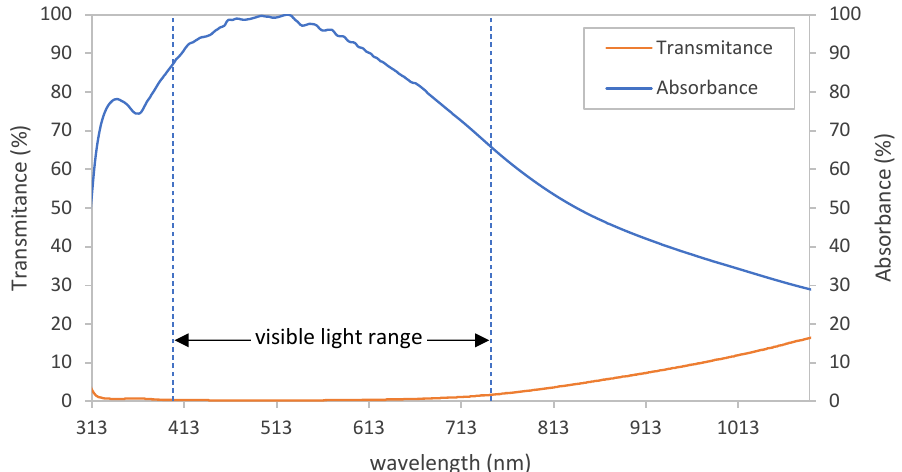
Figure 13. UV-Vis analysis of pyrite thin film on a glass substrate. Figure 13 . UV ‐ Vis analysis of pyrite thin film on a glass substrate.